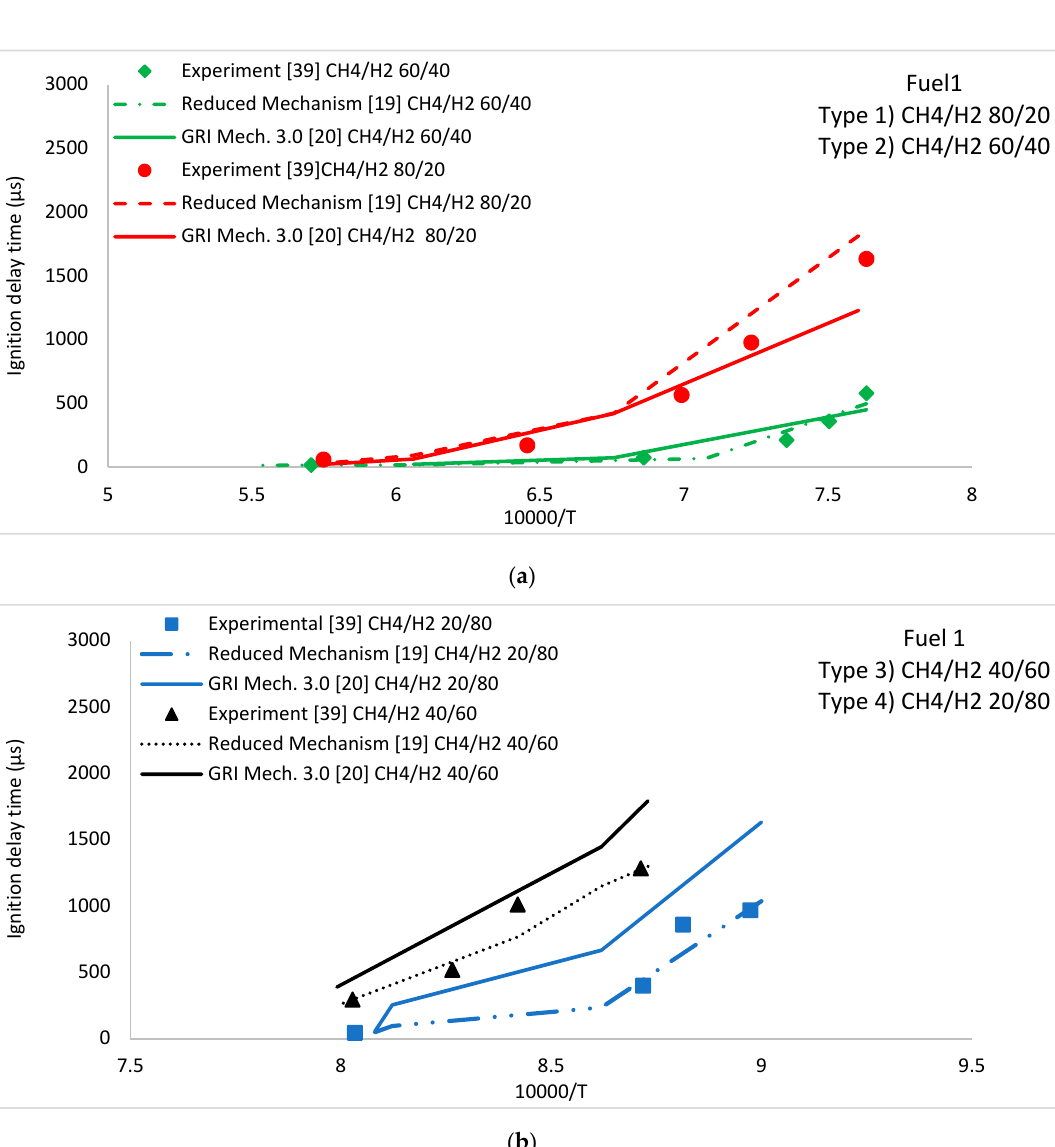
Figure 2. Comparison of the calculated ignition delay time by using the reduced mechanism [19] and GRI Mech. 3.0 [20] and the experimental measurements from Reference [39] for ( a ) Fuel 1 Type 1 and Type 2; and ( b ) Fuel 1 Type 3 and Type 4 at pressure 10 bar and equivalence ratio 0.5.